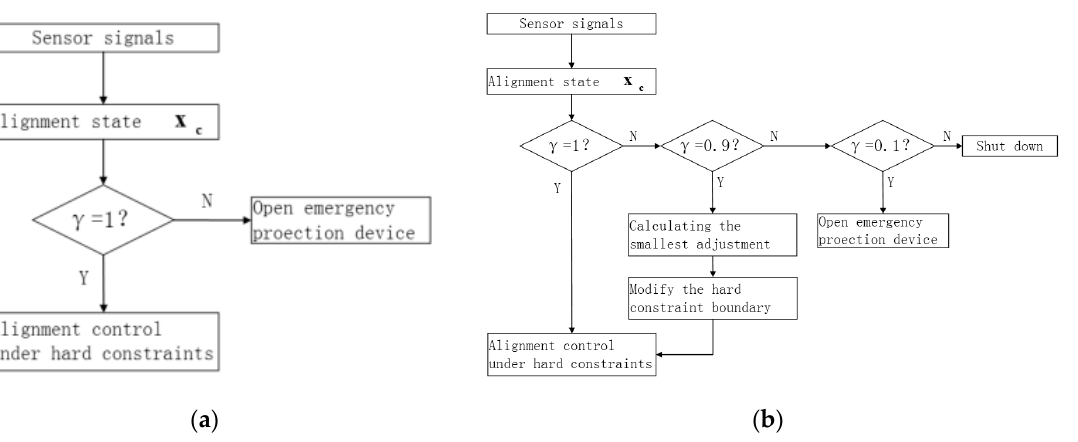
Figure 3. Control flow chart: ( a ) The alignment control method under hard constraints; ( b ) The alignment autonomous control method.